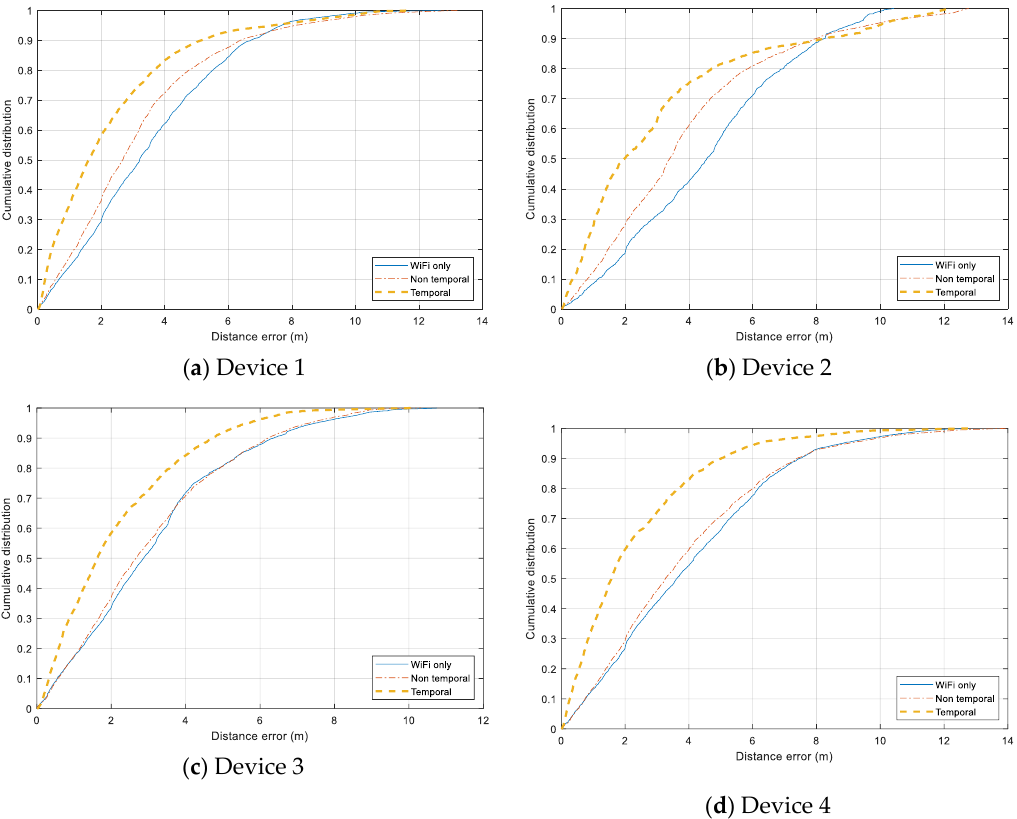
Figure 14. Cumulative distance error distribution for each testing device. ( a ) Samsung Galaxy Note 4 smartphone. ( b ) HTC One ME smartphone. ( c ) Asus ME tablet. ( d ) Samsung Galaxy Tab tablet.